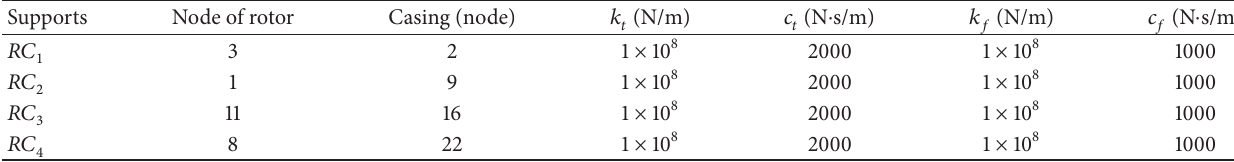
Table 5: Support parameters of rotor-casing.